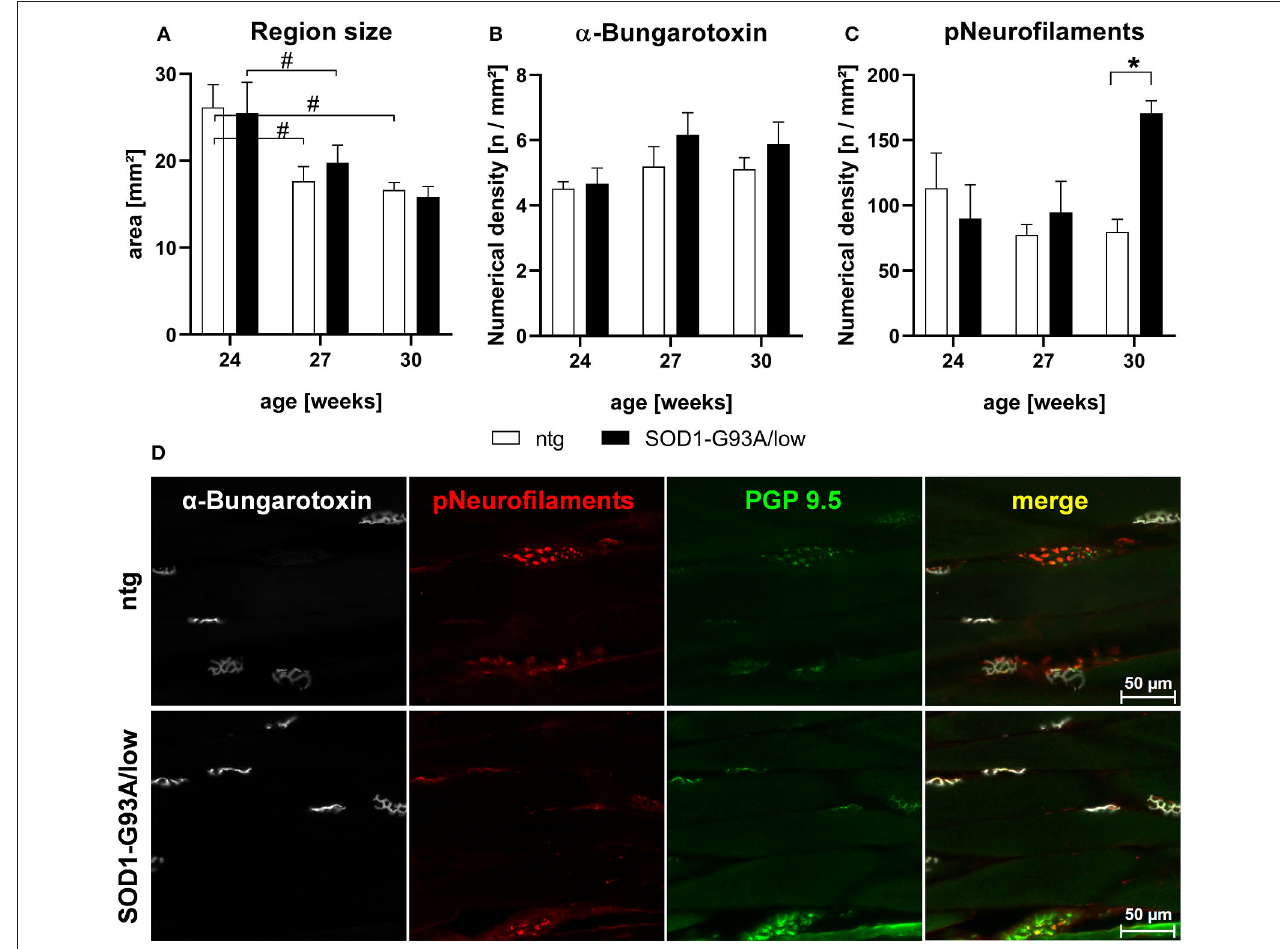
FIGURE 4 | Histological analysis of the musculus gastrocnemius of 24–30 weeks old SOD1-G93A/low mice. The musculus gastrocnemius of 24, 27, and 30 weeks old male SOD1-G93A/low mice was evaluated for region size (A) , numerical density of acetylcholine receptors at the postsynaptic surface of neuromuscular junctions by fluorophore-conjugated α -bungarotoxin labeling (B) , and numerical density of phosphorylated neurofilaments (C) compared to ntg littermates. Two-way ANOVA with Tukey’s and Sidak’s multiple comparison post hoc test; n = 4 per group. Mean + SEM. */ # p < 0.05. (D) Representative images of α -bungarotoxin (white), phosphorylated neurofilaments (pNeurofilaments, red), and protein gene product (PGP) 9.5 (green) triple labeling in the musculus gastrocnemius of a 30 weeks old male SOD1-G93A/low mouse compared to ntg